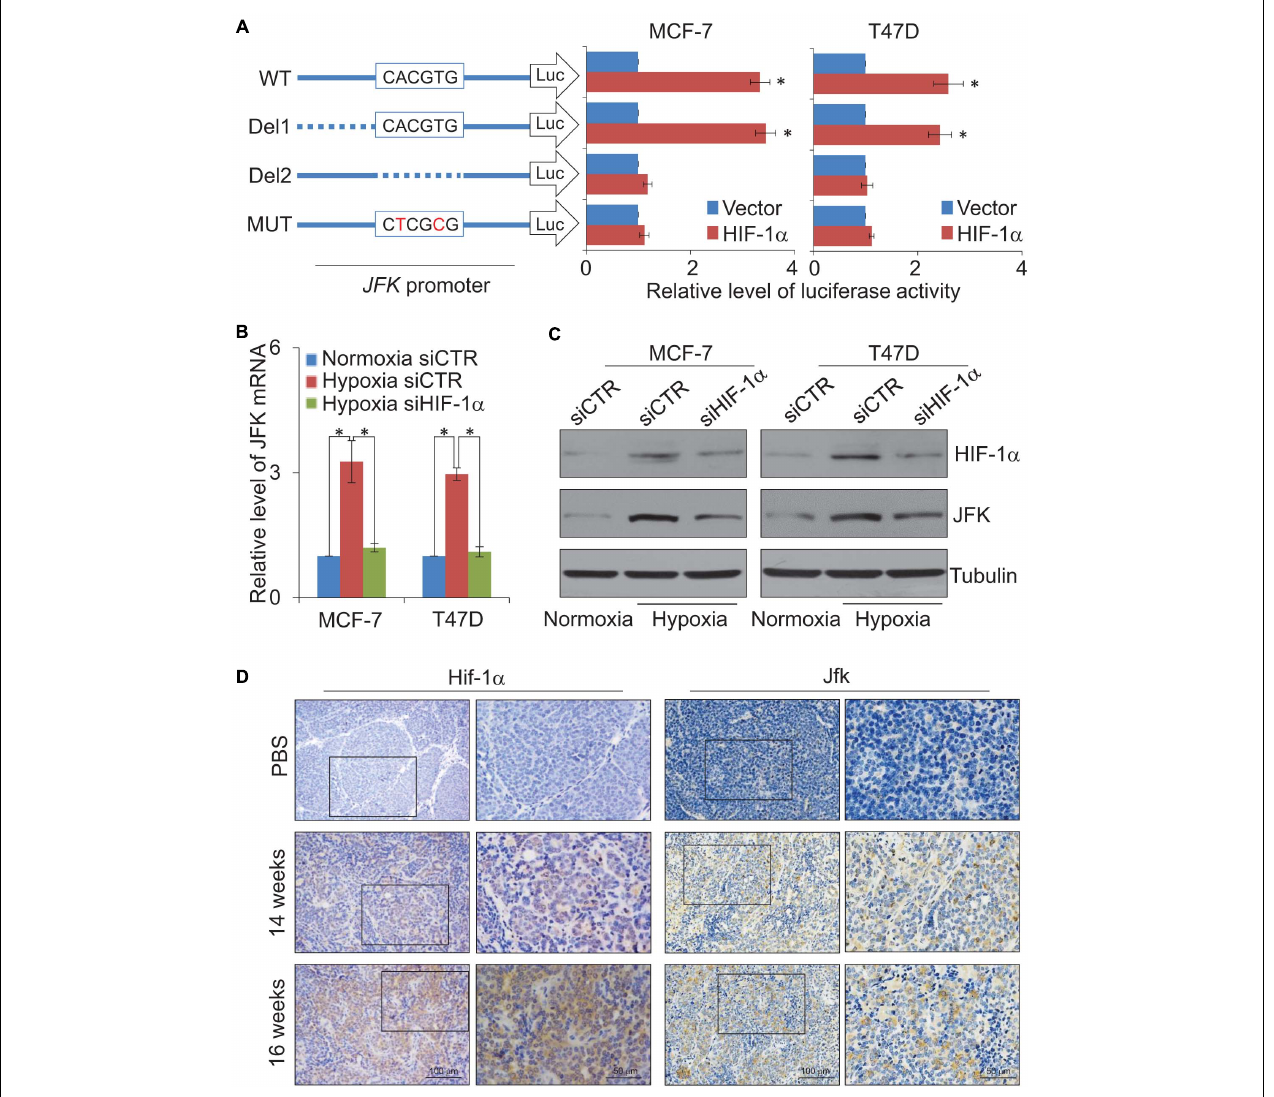
FIGURE 3 | JFK is transcriptionally activated by HIF-1 α . (A) MCF-7 or T47D cells infected with lentiviruses carrying JFK -Luc wild-type, deletion, or mutant variants, as well as control vector or HIF-1 α expression constructs, were harvested, lysed, and assayed for firefly and Renilla luciferase activity using the dual-luciferase reporter assay system. Error bars represent the mean ± SD for triplicate experiments. (B) qPCR measurement of the JFK expression in MCF-7 or T47D cells treated with control or HIF-1 α siRNAs, under normoxia or hypoxia (1% O 2 ) for 24 h. Error bars represent the mean ± SD for triplicate experiments. (C) Western blotting analysis of cellular extracts from MCF-7 or T47D cells treated with control or HIF-1 α siRNAs, under normoxia or hypoxia (1% O 2 ) for 24 h. (D) Immunohistochemical staining of breast tumors from 14-week-old or 16-week-old JFK WT / PyMT TG mice to assess the expression of Hif-1 α and Jfk. Statistical significance of differences is indicated as * p <